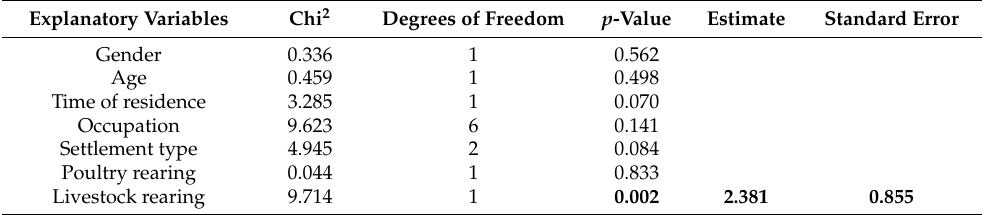
Table 6. Deviance analysis results showing the effect of each factor used in the binomial generalized linear model for the response variable conflicts with Pumas and their significance, performed with the Anova function of “car” package. Explanatory variables with p -values < 0.05 are in bold. The estimated coefficient and standard error are shown for the significant category (yes) of the significant social factor.